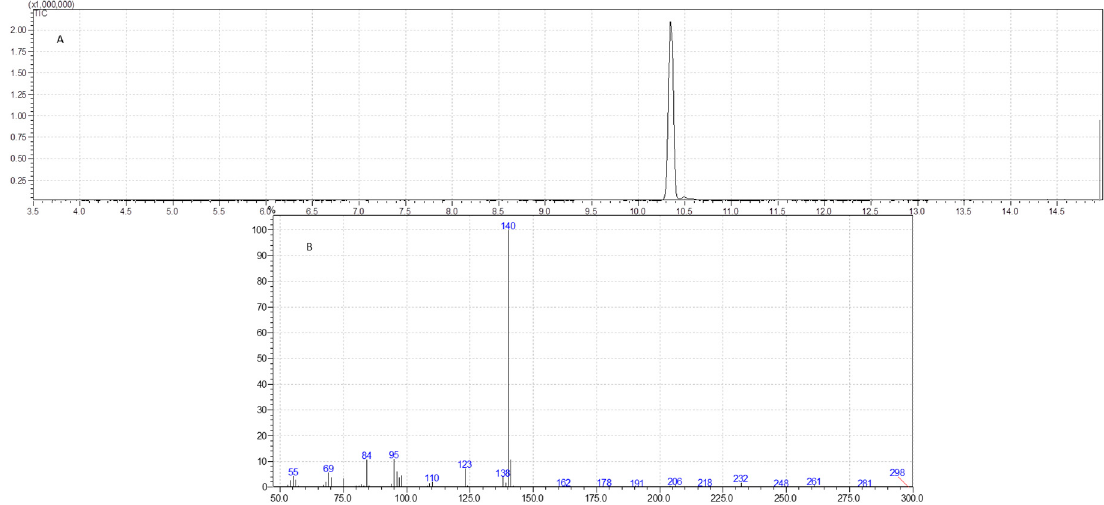
Figure 17. Gas chromatography ( A ) and mass spectrometry data ( B ) of 4F-PHP ( 3 ).